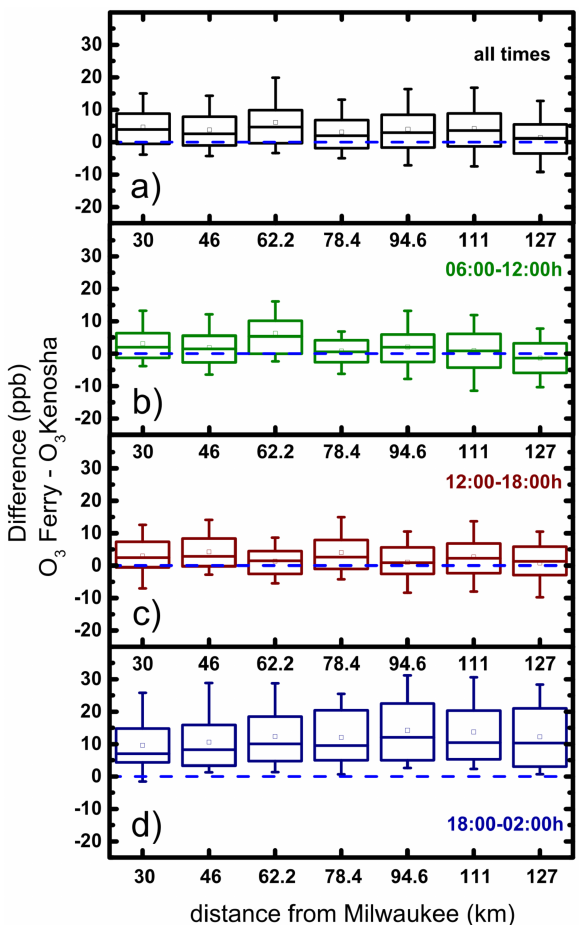
Figure 6. Difference in O 3 observations between platforms with respect to position of the ferry as indicated by kilometers from Milwaukee along ferry path at (a) all times, (b) morning (06:00– 12:00CDT), (c) early afternoon (12:00–16:00CDT) and (d) late afternoon/evening (16:00–02:00h). Box plots show mean ( (cid:3) ), me- dian (centerline), 25–75% (box) and 10–90% (whiskers). Each box plot represents a minimum of 12 points.